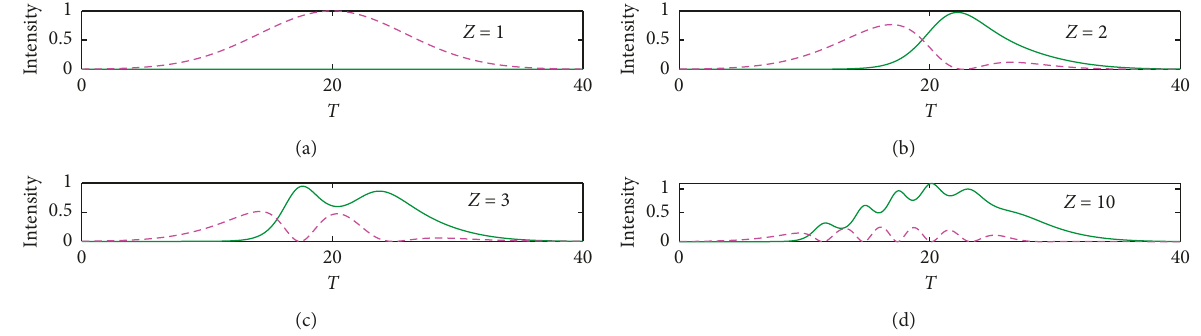
Figure 2: Normalized intensity profiles of the pump (dashed magenta) and Stokes (solid green) pulses at several propagation distances. The � coherent memory parameter is taken to be Γ c